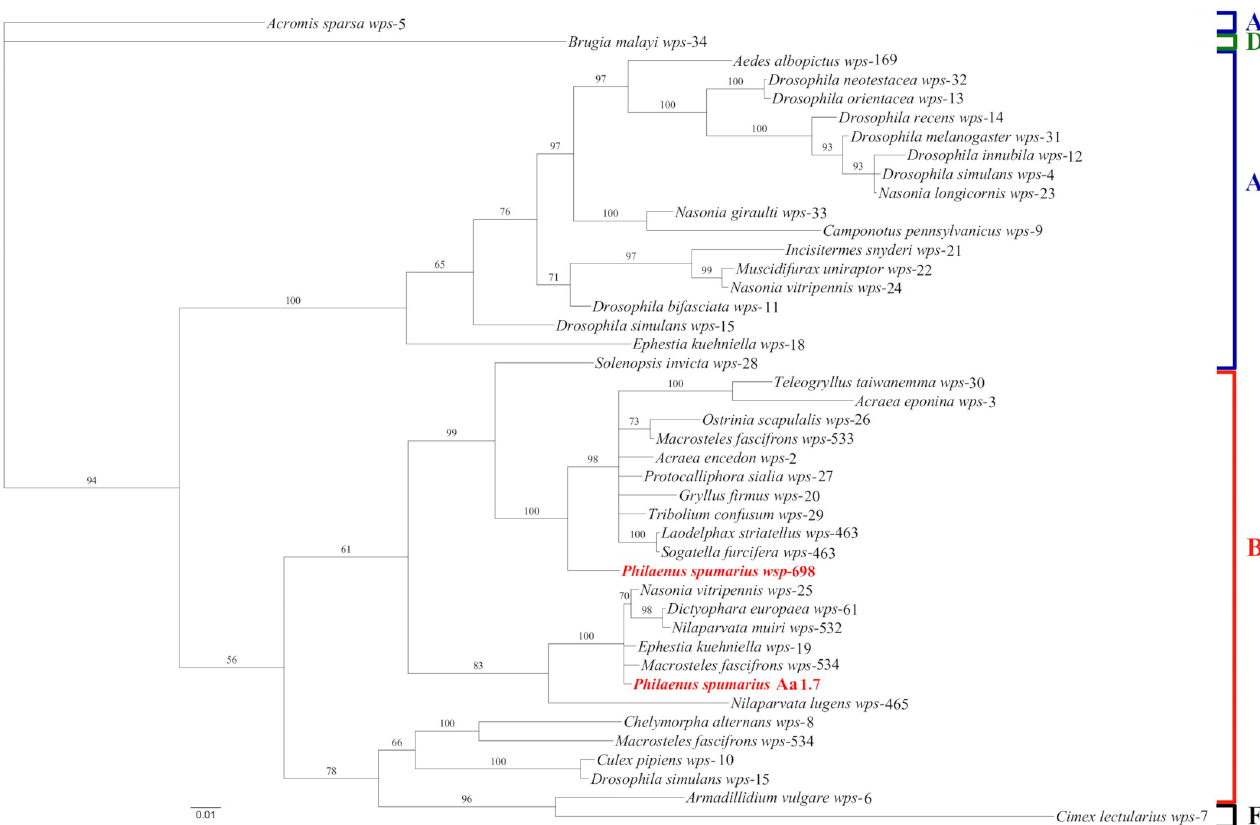
Fig 3. Bayesian phylogenetic tree for wsp gene sequences of Wolbachia . Strains of Wolbachia found in Philaenus spumarius and sequenced in this work are shown in bold red. Reference Wolbachia strains were imported from the MLST database. Wolbachia strains are indicated with the name of the host species followed by the number of the wsp allelic variant. Based on the information reported in the MLST database for the reference strains, the letters on the right indicates the Wolbachia supergroups.